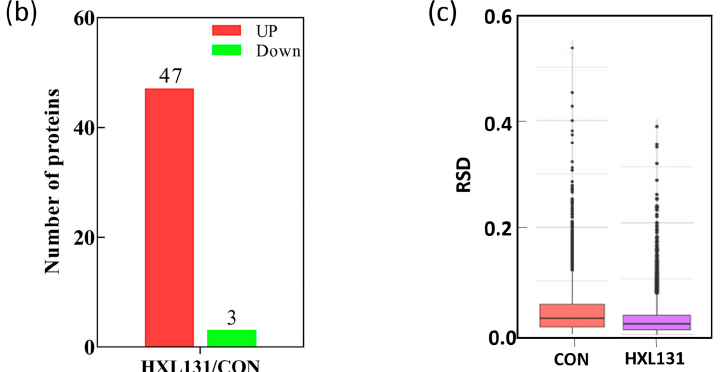
Figure 3. Tandem mass tag (TMT) quantitative proteomics analysis of differentially expressed proteins (DEPs). ( a ) Systematic workflow diagram of TMT labeling-based quantitative proteomic analysis. HPLC: High-performance liquid chromatography. LC-MS/MS: Liquid chromatography-tandem mass spectrometry; ( b ) The number of up-regulated and down-regulated expression proteins (Fold change > 2.0); ( c ) Quantitative relative standard deviation (RSD) of control samples and HXL131-treated samples. Table 1. Differentially expressed proteins between two samples under a fold change > 2.0 ( p -value < 0.05). Type of Regulation Protein Symbol CYR61, IRAK2, B4GALT5, LYPD3,